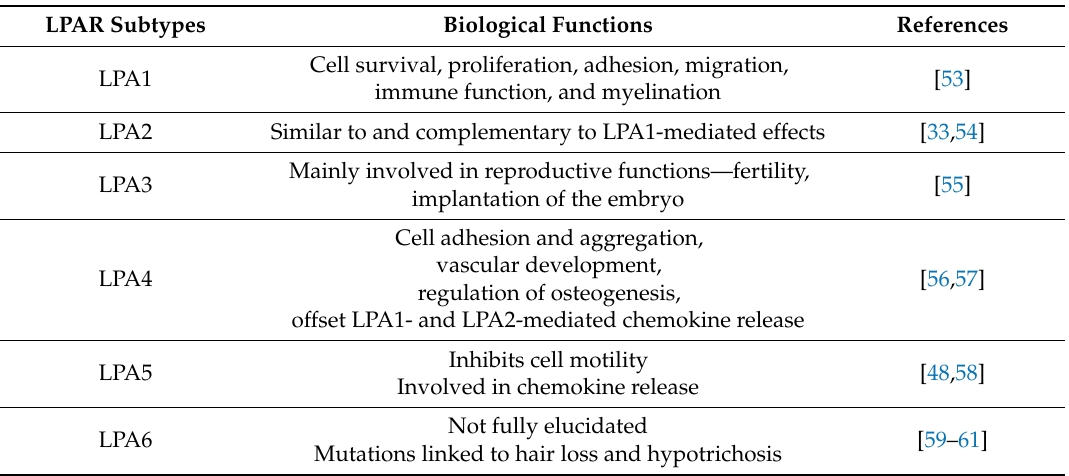
Table 2. LPA receptor subtypes and their biological